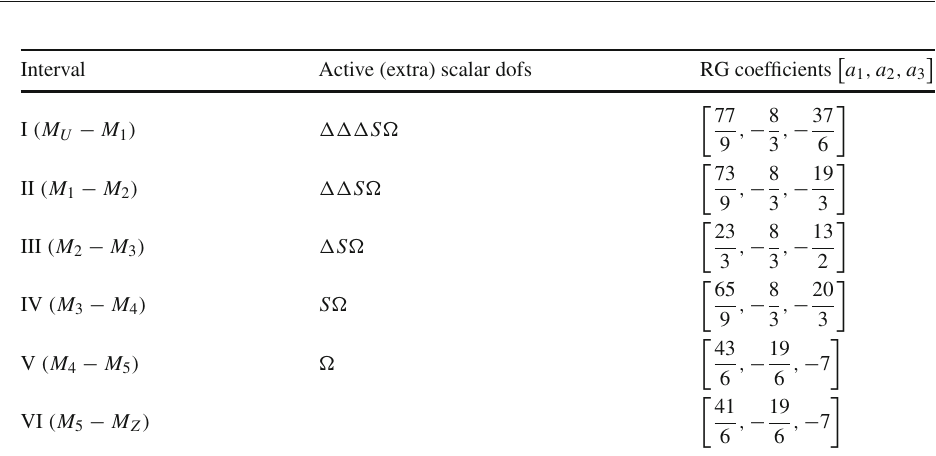
Table 3 The distribution of the new scalars among the energy intervals and the corresponding RG coefficients